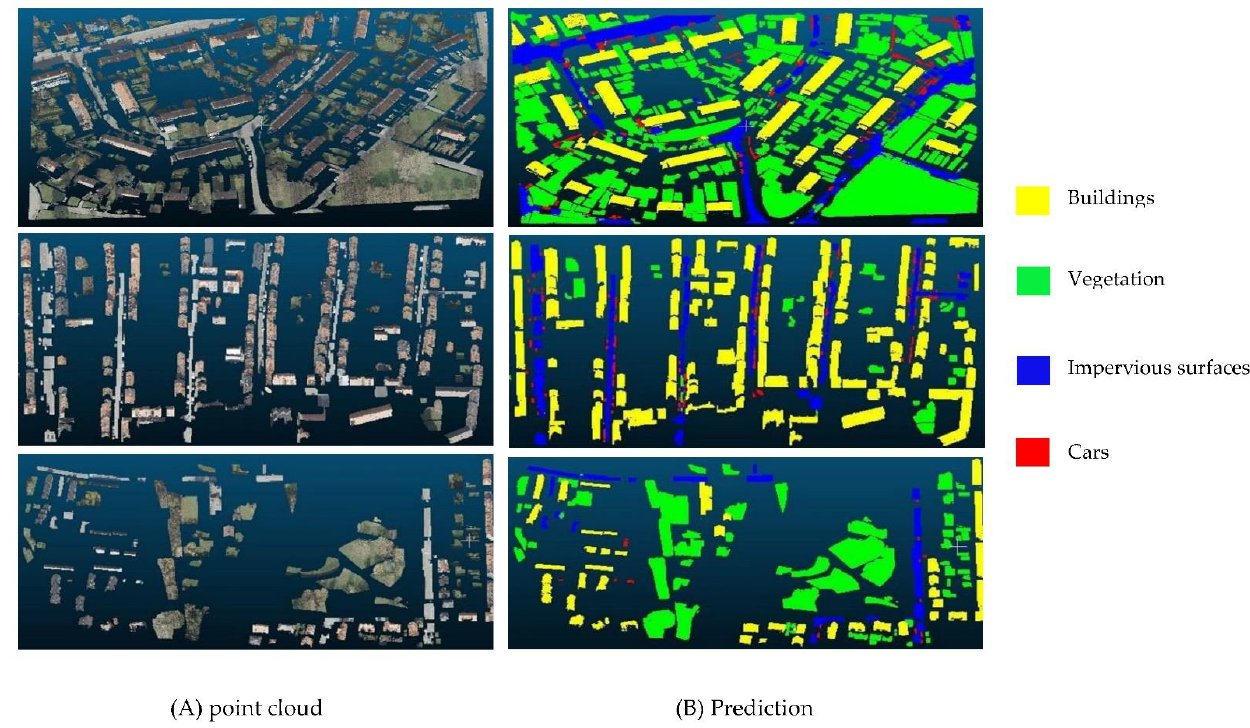
Figure 9. Examples of 3D semantic segmentation results obtained by the Plf4SSeg approach.